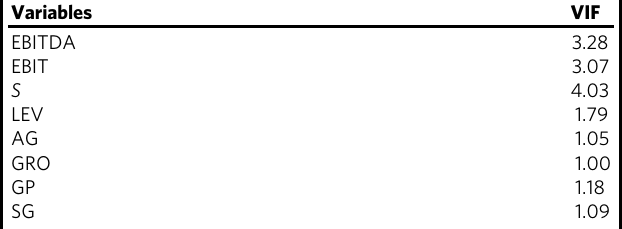
Table 5 Variance in fl ation factor